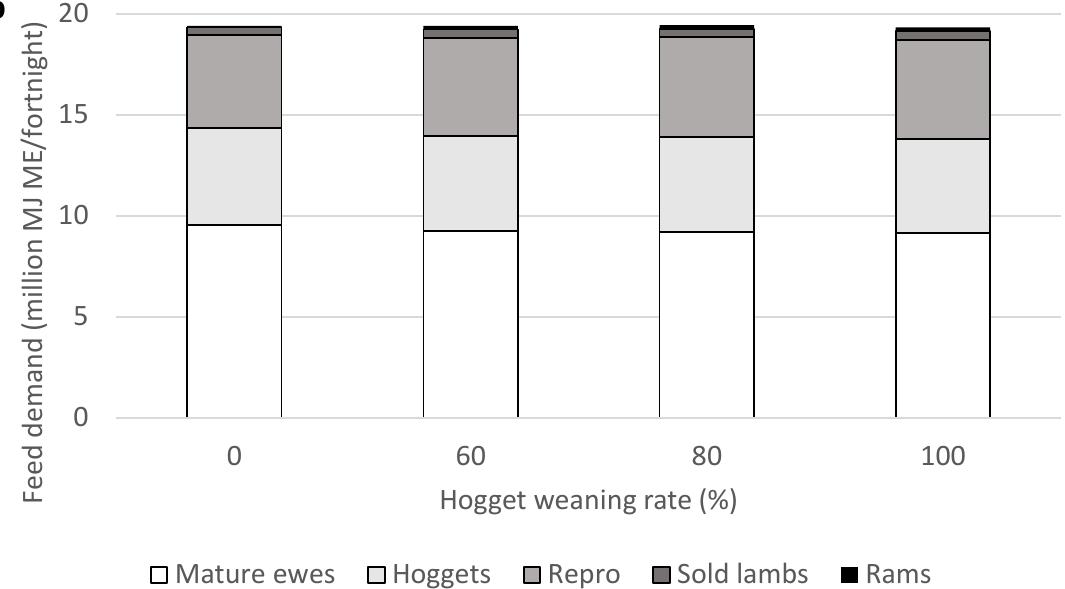
Figure 4. Total annual feed demand for mature ewes (aged two to six years), hoggets, reproduction (gestation and lactation for lamb production), sold lambs, and rams, with varying hogget weaning rates and with mature ewe weaning rates of ( a ) 132% and ( b ) 150%.